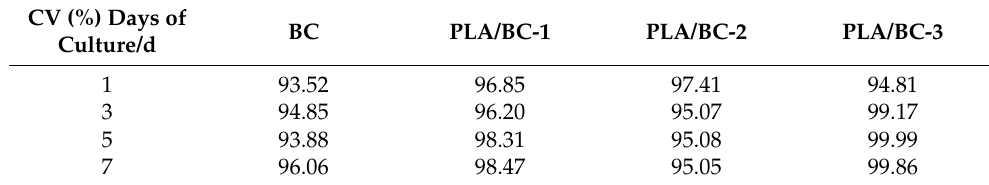
Table 3. Relative Growth Rate of BC membranes and PLA/BC composite scaffolds.